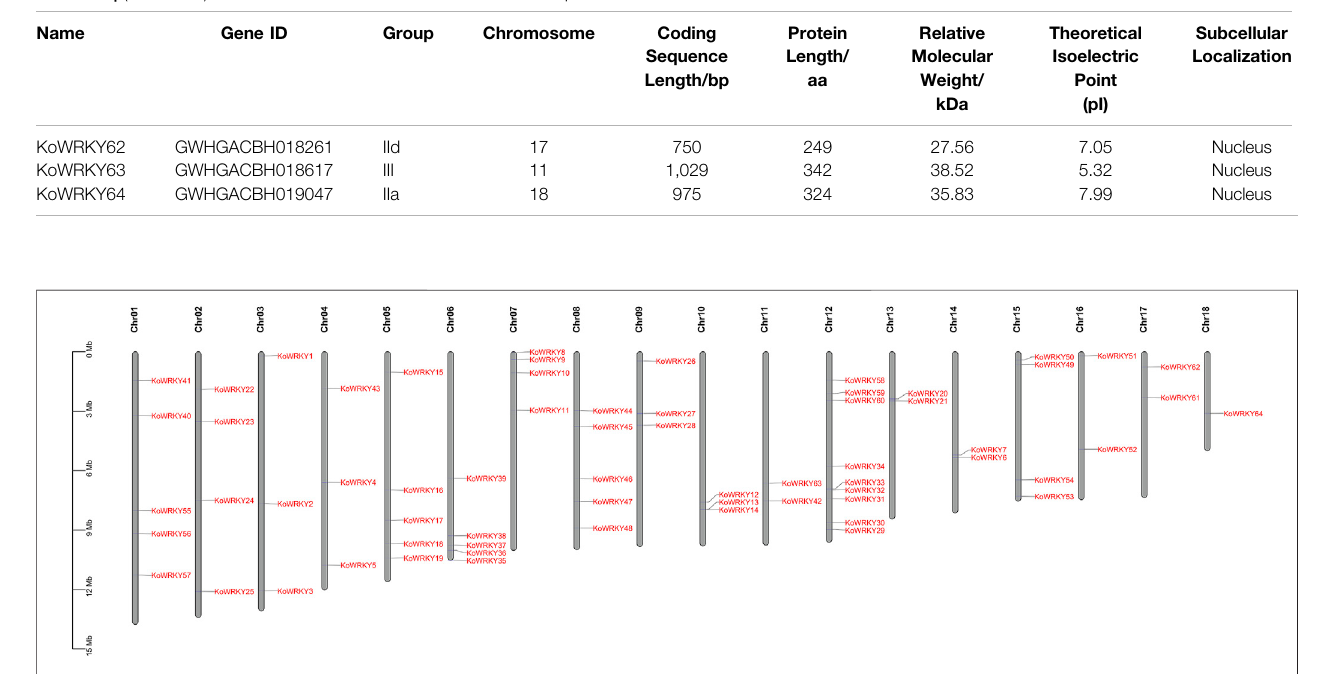
Supplementary Table S2 . The cis -elements related to plant